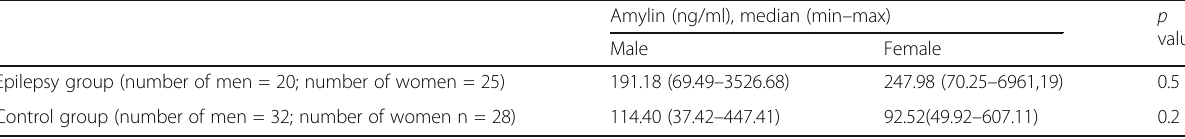
Amylin (ng/ml), median (min – max)